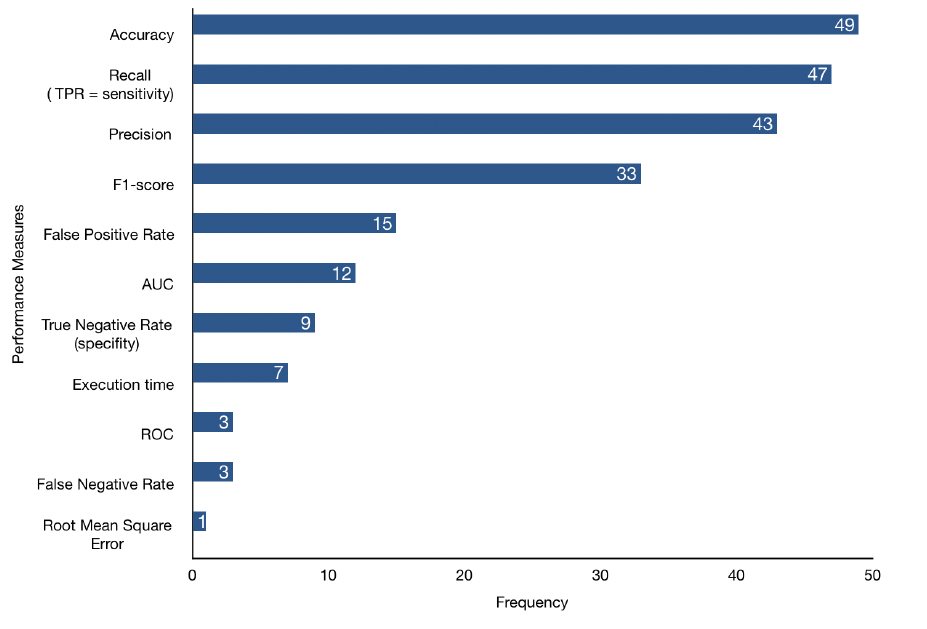
Figure 11. Histogram of performance metrics used in selected